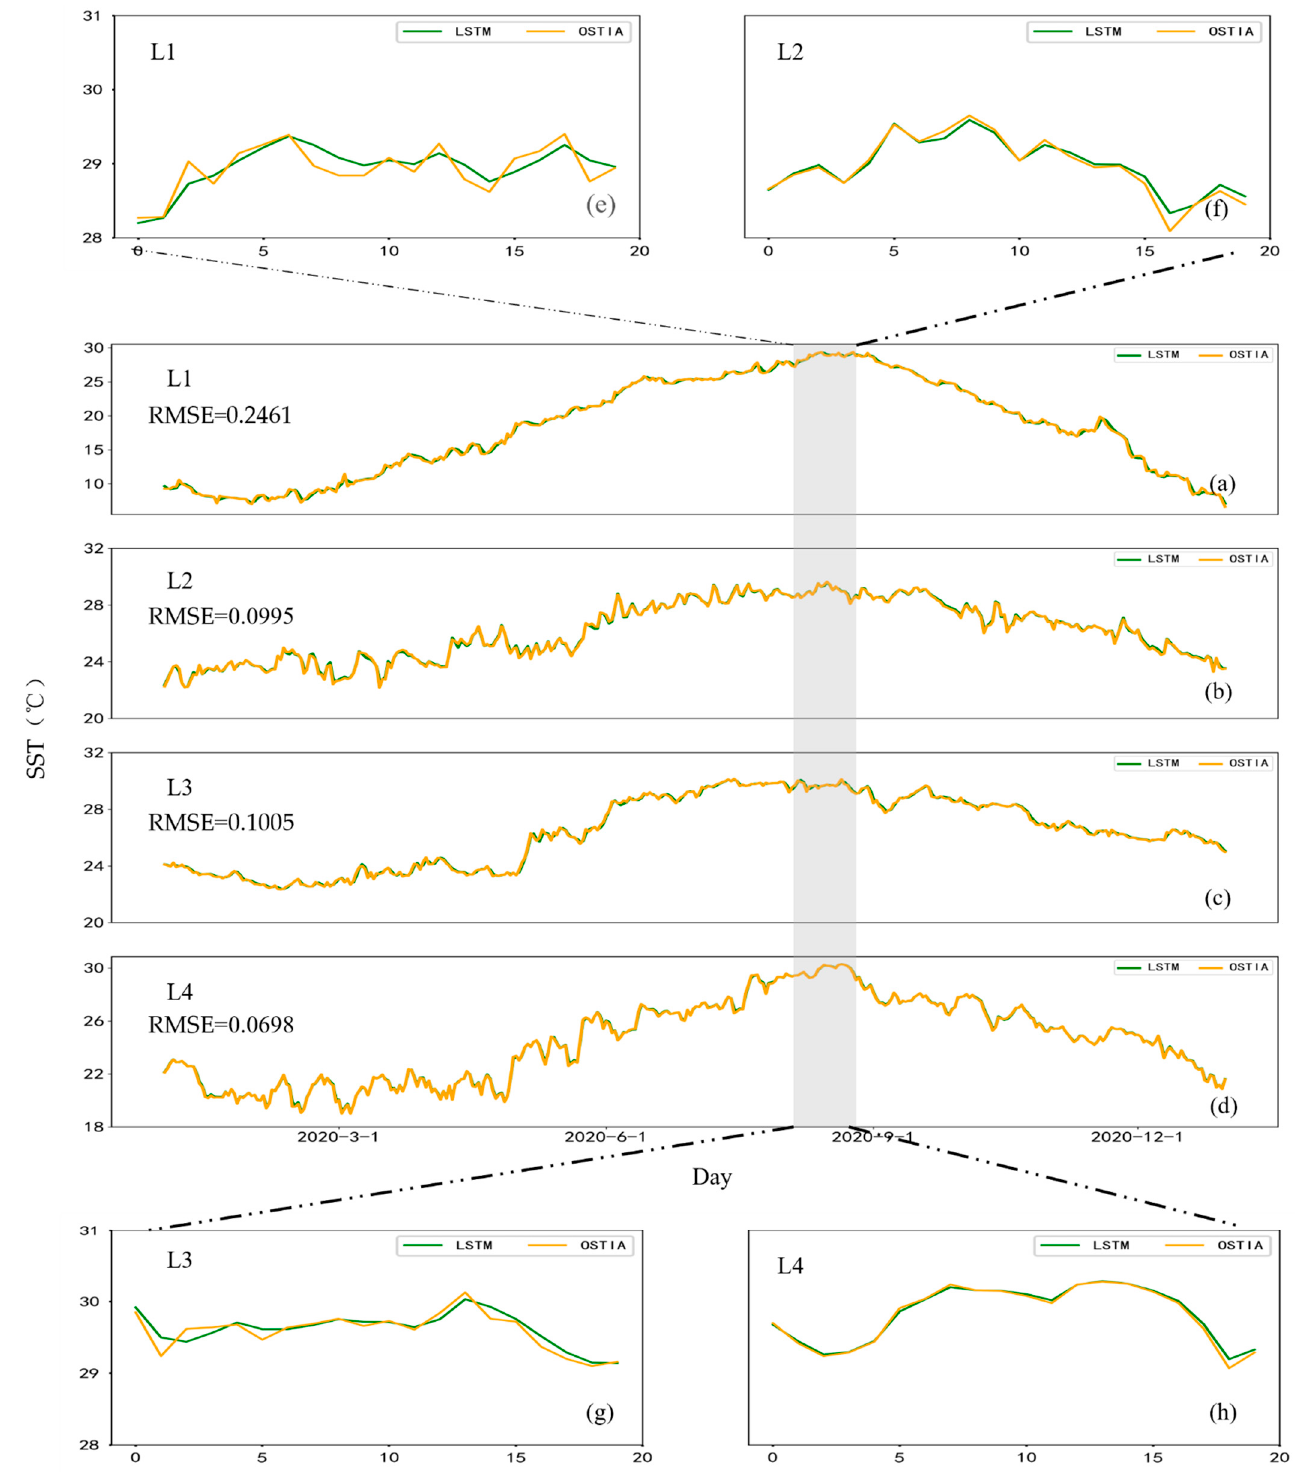
Figure 5. OSTIA data and LSTM predictions at different points, where the green line is the prediction result of LSTM, the yellow line is the OSTIA data, and the gray rectangle is the area where the maximum SST is located in 2020. ( a – d ) are in a comparison chart of the LSTM prediction results and OSTIA data in 2020. ( e – h ) are the values of the region where the maximum SST is located in 2020. The abscissa is the SST in degrees Celsius, and the ordinate is the number of days.